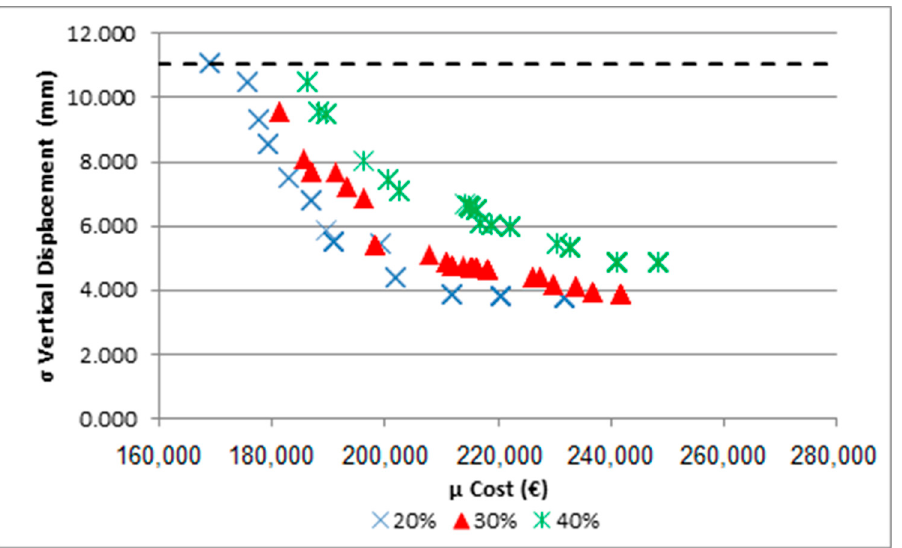
Table 9. Comparison of different designs of the Pareto Frontier with a 20% variation of the overload.